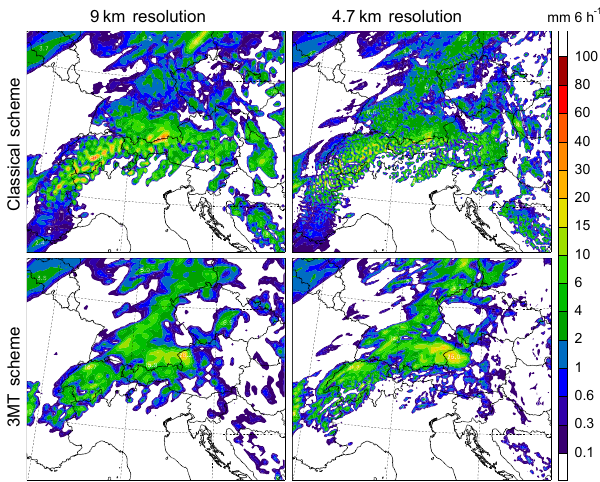
Figure 5. Precipitation accumulated between the + 12 and + 18h forecast times starting on 21 June 2006 at 00:00UTC given by the ALARO application in CHMI (Prague). The chosen case is a sum- mer convection in central